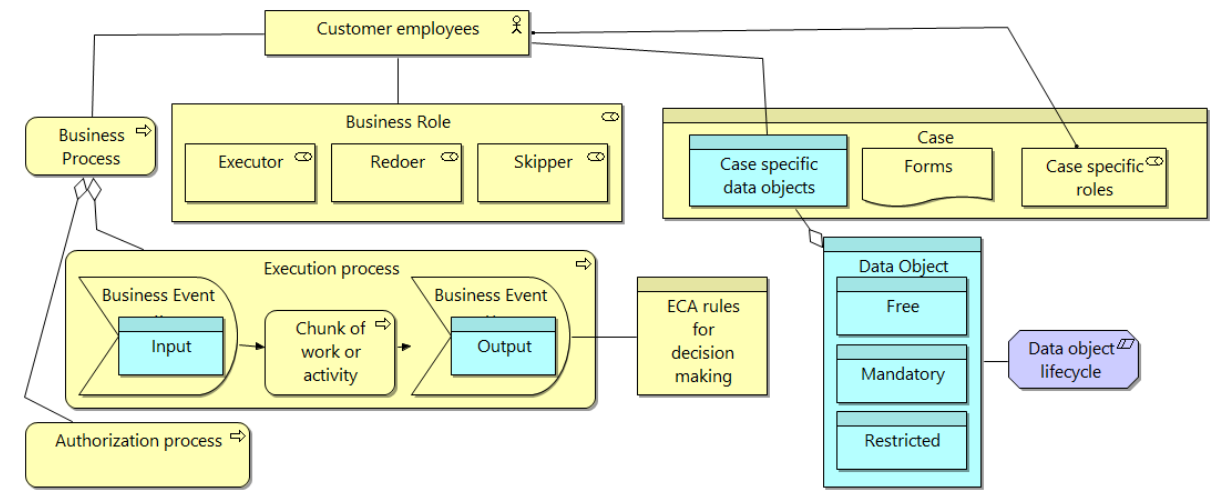
Figure 5. Enterprise model elements for monitoring CBP (the case handling paradigm)